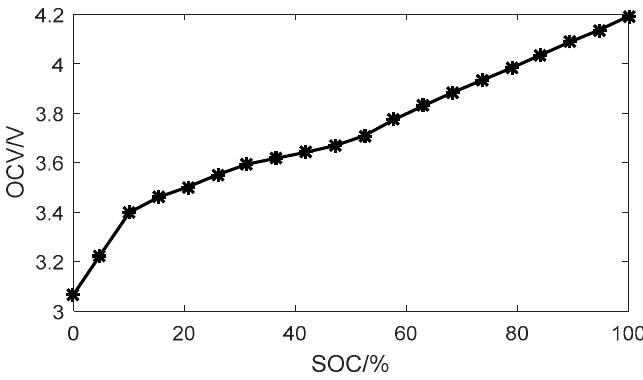
V m Figure 1. Second-order RC equivalent circuit model. The SRCECM consists of the following: (1) The capacitor Q n represents the total stored energy in the battery. The controlled voltage source V oc (SOC) is used to establish the nonlinear relationship between the SOC and the OCV, as shown in Figure 2. (2)